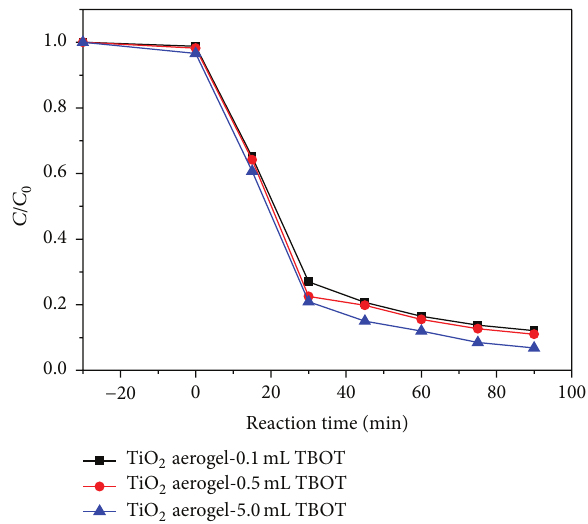
Figure 7: The degradation curves of MO in the presence of the TiO 2 aerogels prepared from 0.1mL of TBOT, 0.5 mL of TBOT, and 0.5 mL of